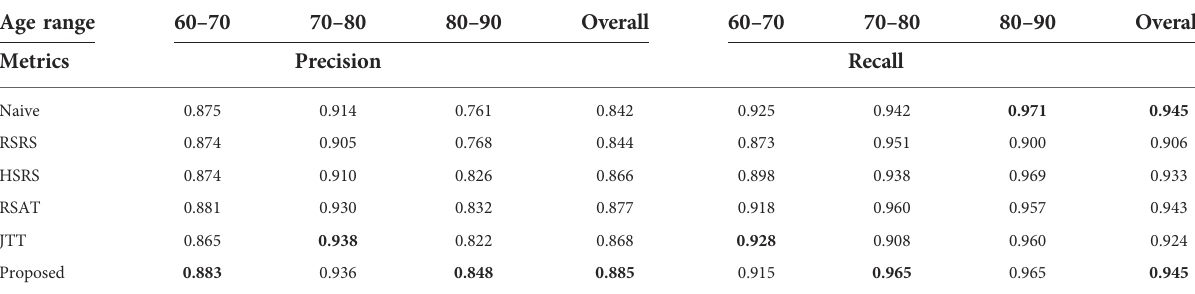
TABLE 3 The test precision and recall values for all